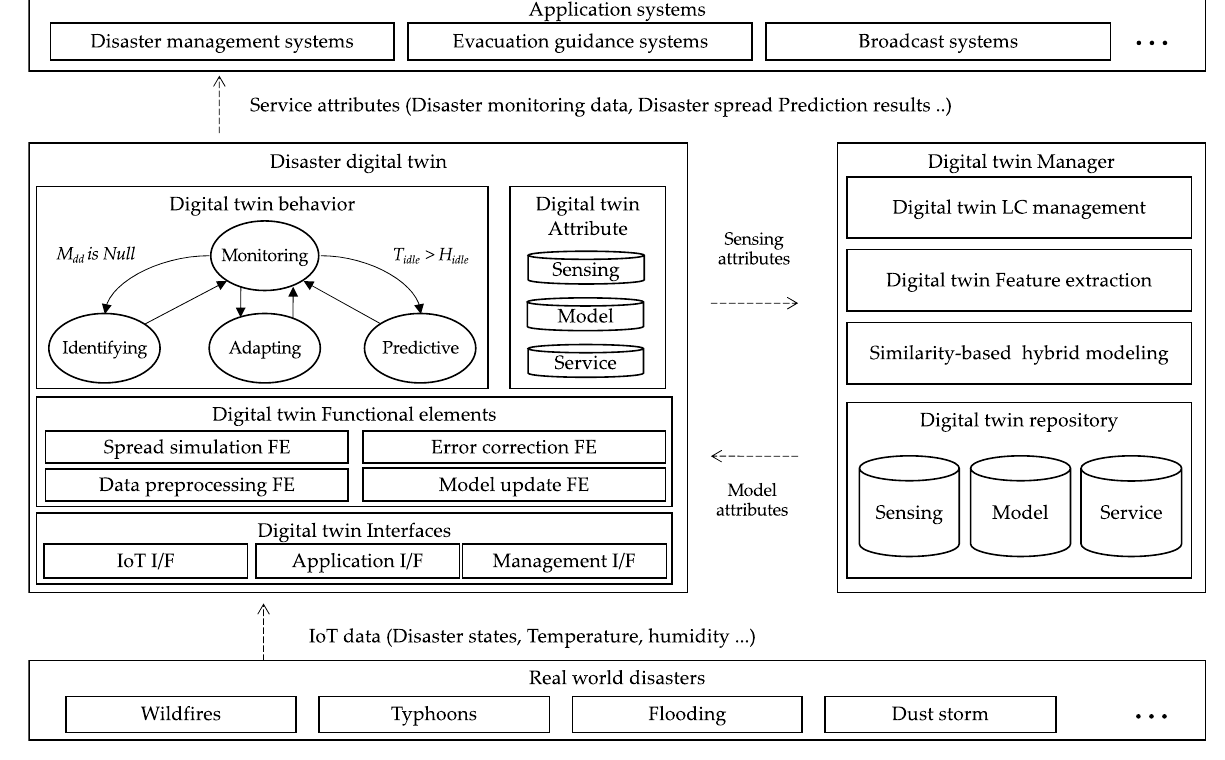
Figure 1. The proposed digital twin architecture.